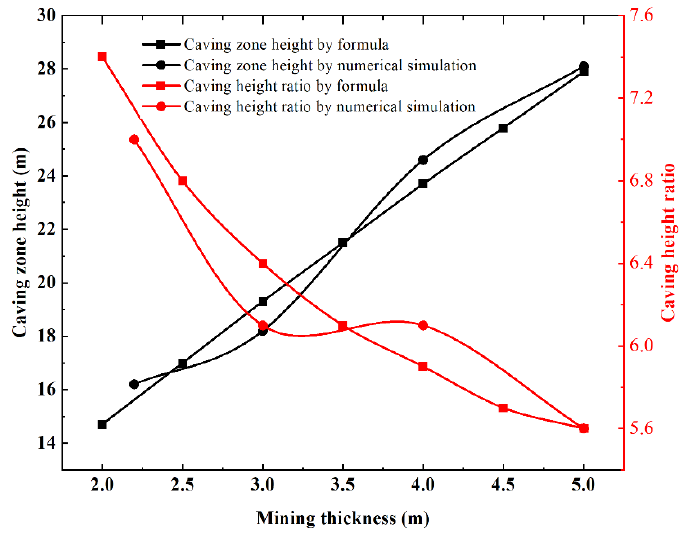
Figure 12. Curves of height and caving height ratio of the caving zone.